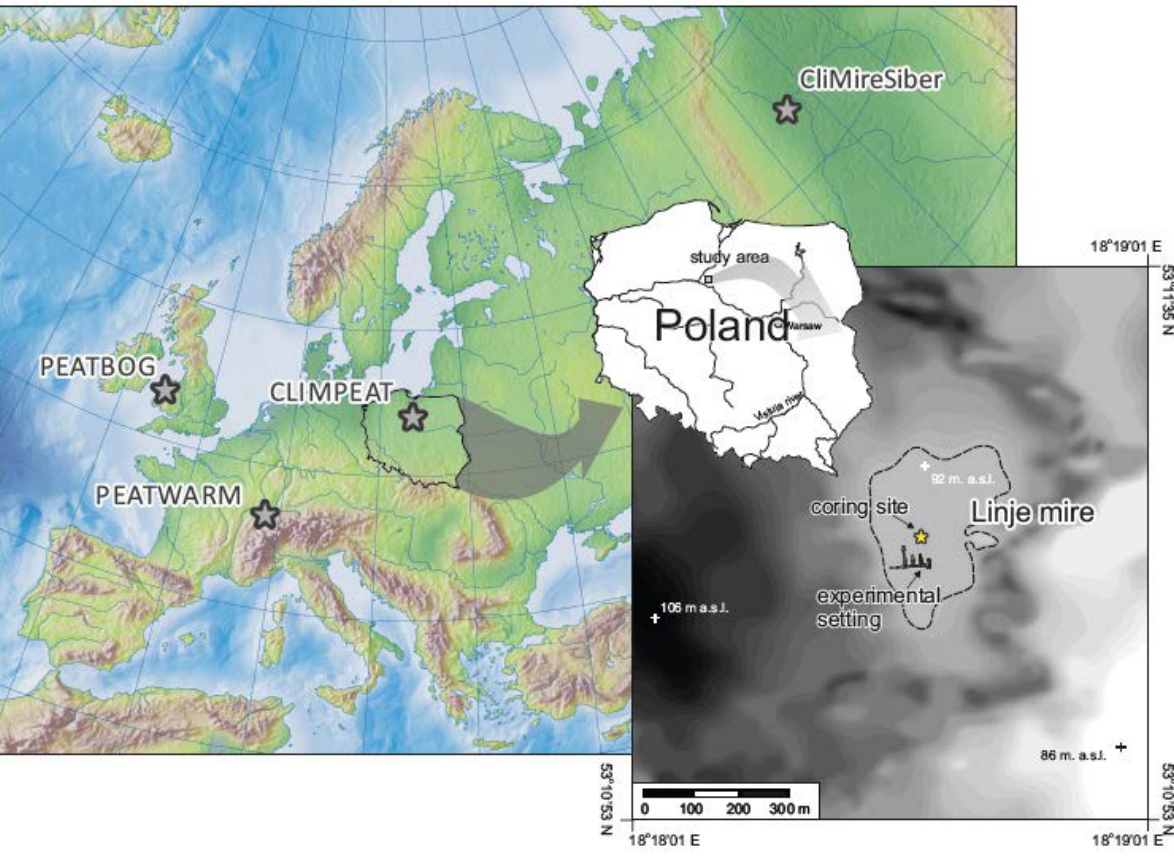
Figure 1. Location of the Linje Mire experimental and palaeoecological sampling site. The sites of similar experiments in France (PEATWARM), England (PEATBOG) and Russia (CliMireSiber) are also